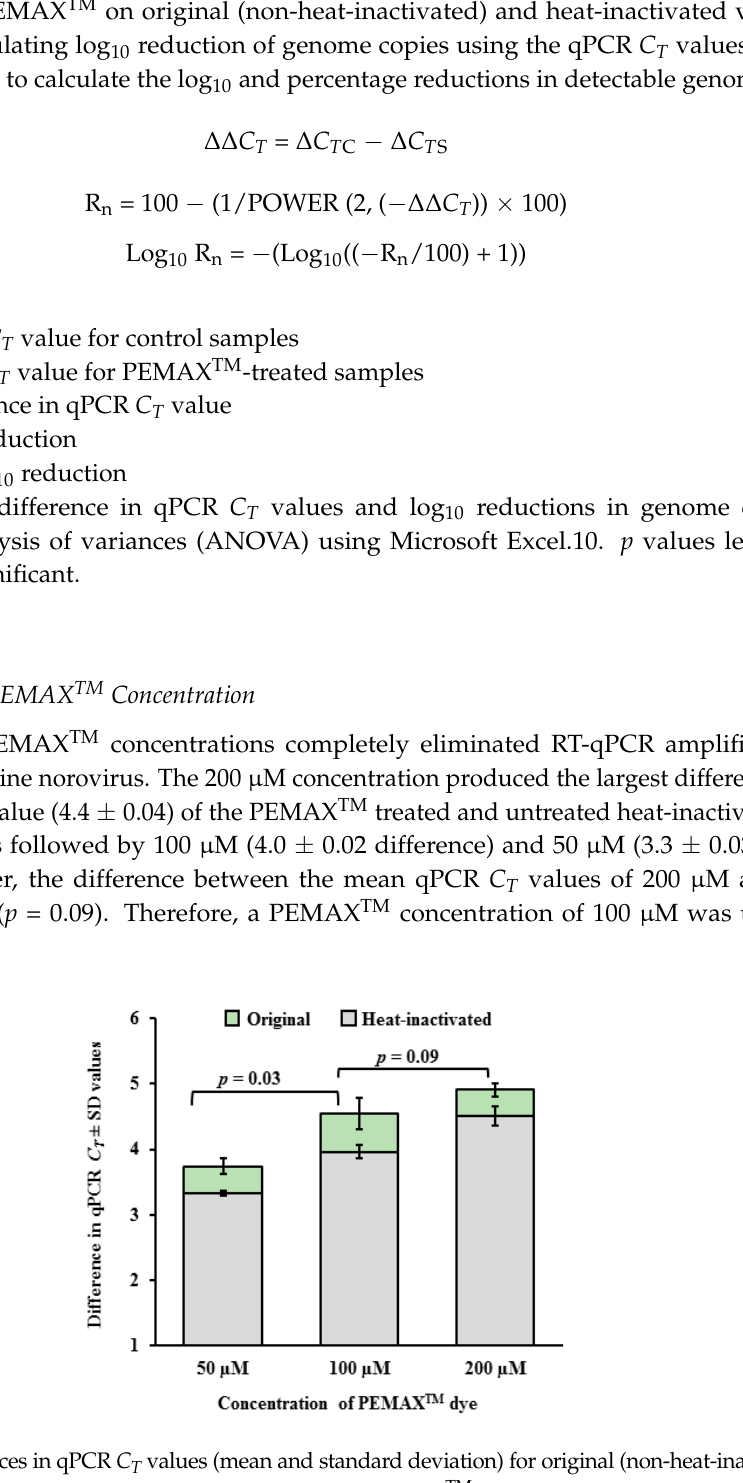
Figure 1. Differences in qPCR C T values (mean and standard deviation) for original (non-heat-inactivated) and heat-inactivated murine norovirus with and without PEMAX TM